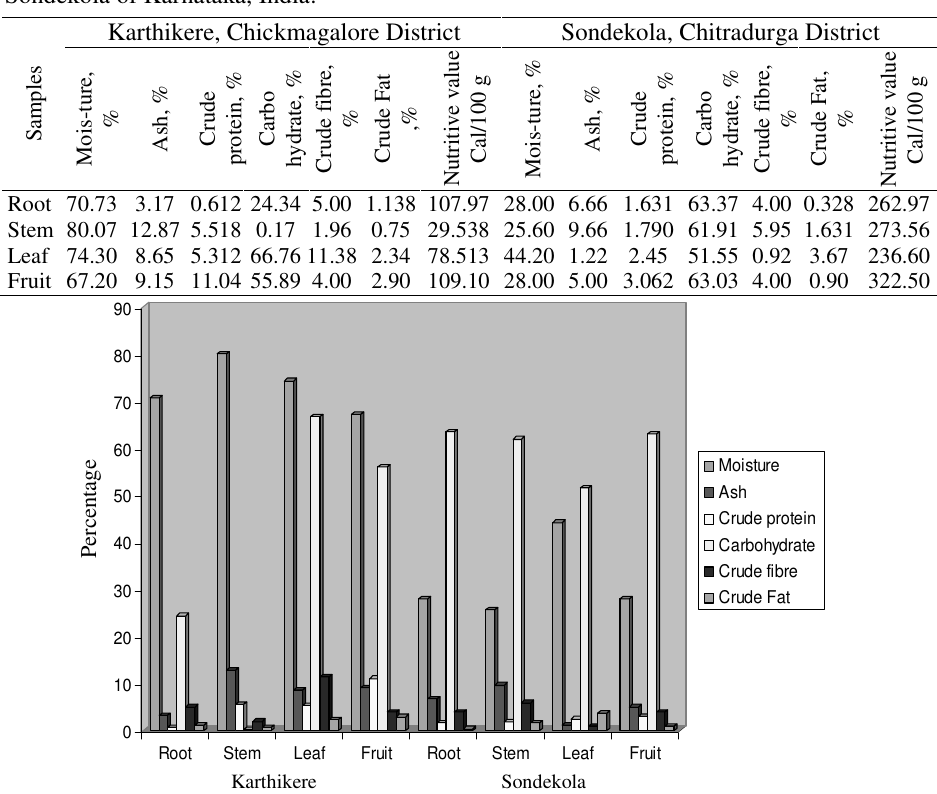
Table 3. Comparative account of components of nutritive values and nutritive values of the root, steam, leaf and fruits samples of Withania somnifera (Linn.) Dunal at Karthikere and